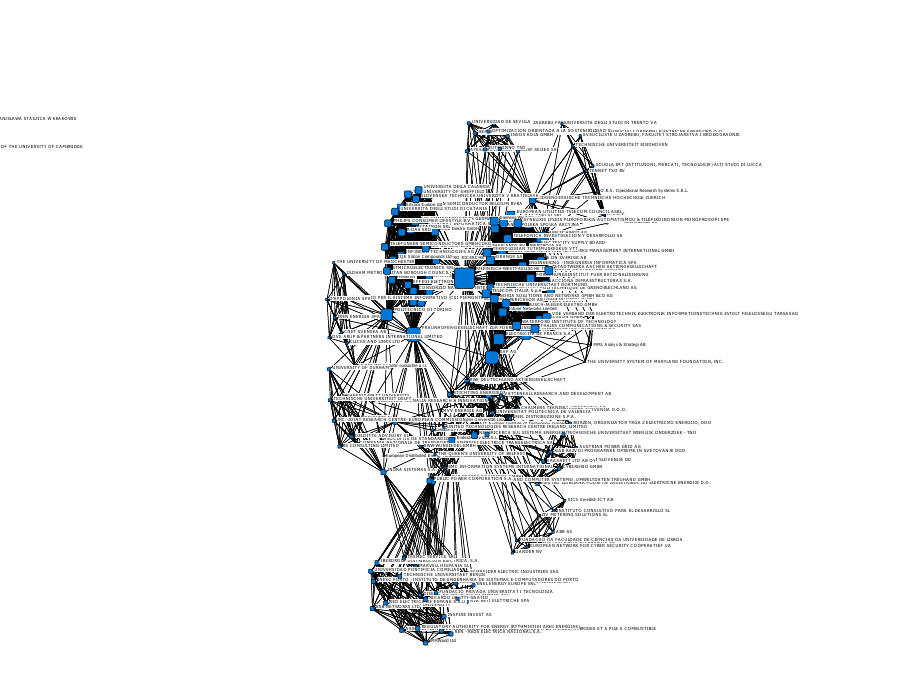
Figure 8. FP7 Generic Grid projects. Social network based on Freeman degree centrality, two main sub-networks (N = 16